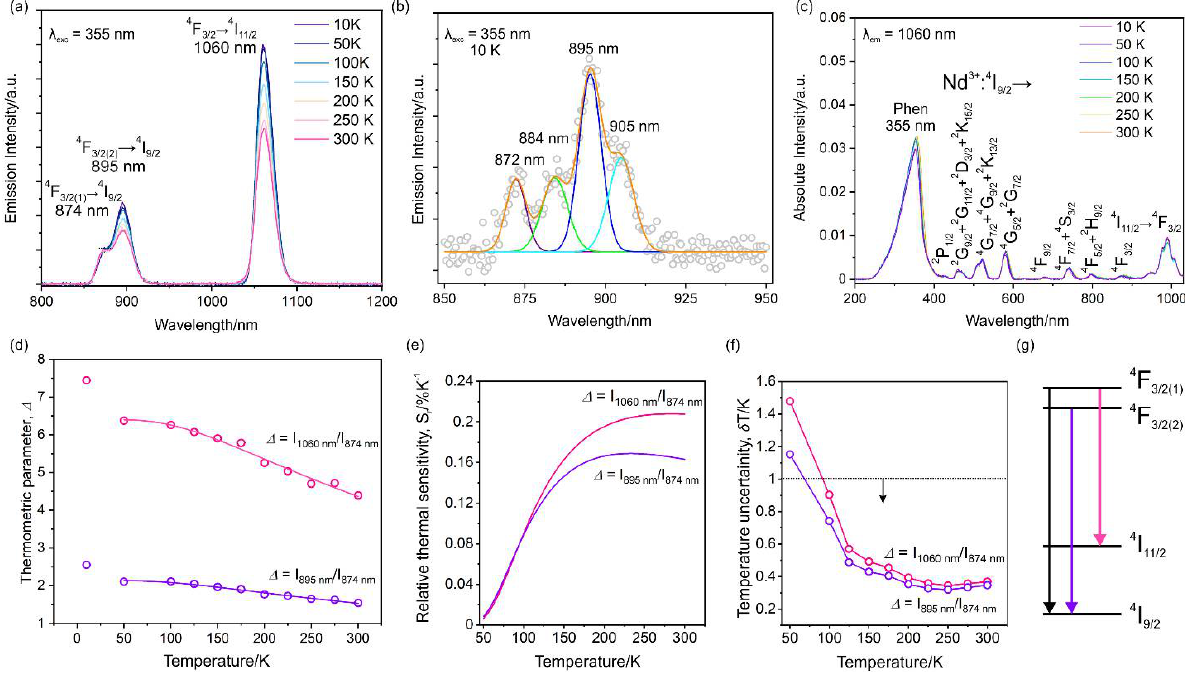
Figure 5. ( a ) Temperature-dependent emission spectra of 1-S . ( b ) Deconvoluted high-resolution emission spectrum measured at 10 K for 1-S with a 355 nm excitation light. ( c ) Temperature-dependent excitation spectra of 1-S measured for a 1060 nm emissive peak. The circles for low-temperature spectra in Figure 5b are experimental data, and the solid orange line is a simulated line with deconvoluted four different constituents (brown, green, blue, and cyan) ascribable to the electronic transitions from the lowest state of the 4 F 3/2 multiplet to various states of the 4 I 9/2 multiplet. The full characterization of NIR-based emissive thermometry for 1-S with the Δ being defined as the ratio between peak intensities, evaluated from emission intensities measured at a different temperature, ( d ) thermometric parameters in the 10−300 K range (magenta and olive circles) along with the fi(cid:308)ed line in the range of 50−300 K, ( e ) the evaluated relative sensitivity at a different temperature from the fitted Δ curve, and ( f ) evaluated temperature uncertainty for different temperatures. ( g ) The energy level diagram of ground and excited multiplets involved in the emission.